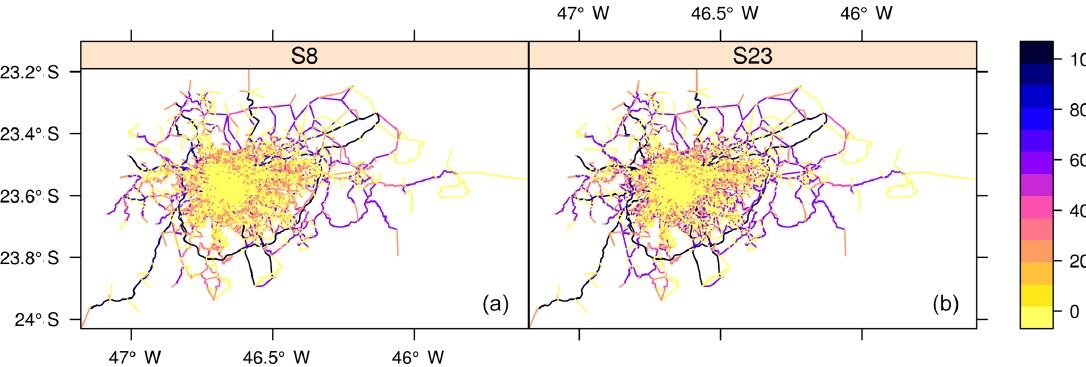
Figure 3. Traffic speeds (colored lines; kmh − 1 ) for LDV fleet at 08:00LT ( a ) and 23:00LT ( b ) in MASP.